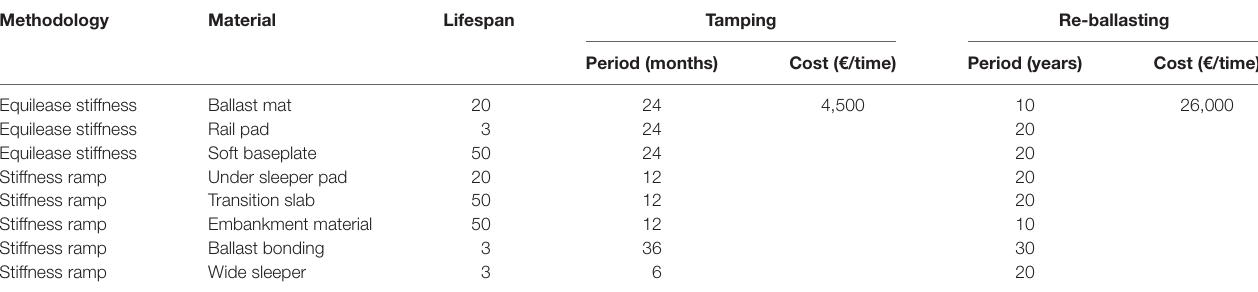
TaBle 5 | Assumptions table for lifespan and maintenance in case of flash flood.